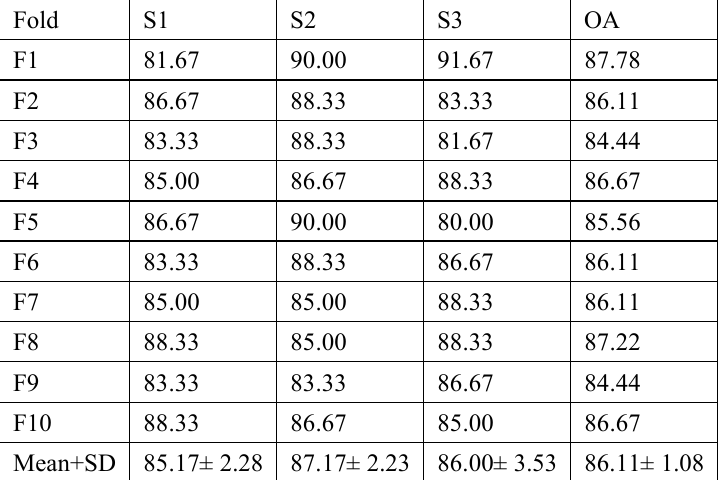
Table 5. Performance analysis of